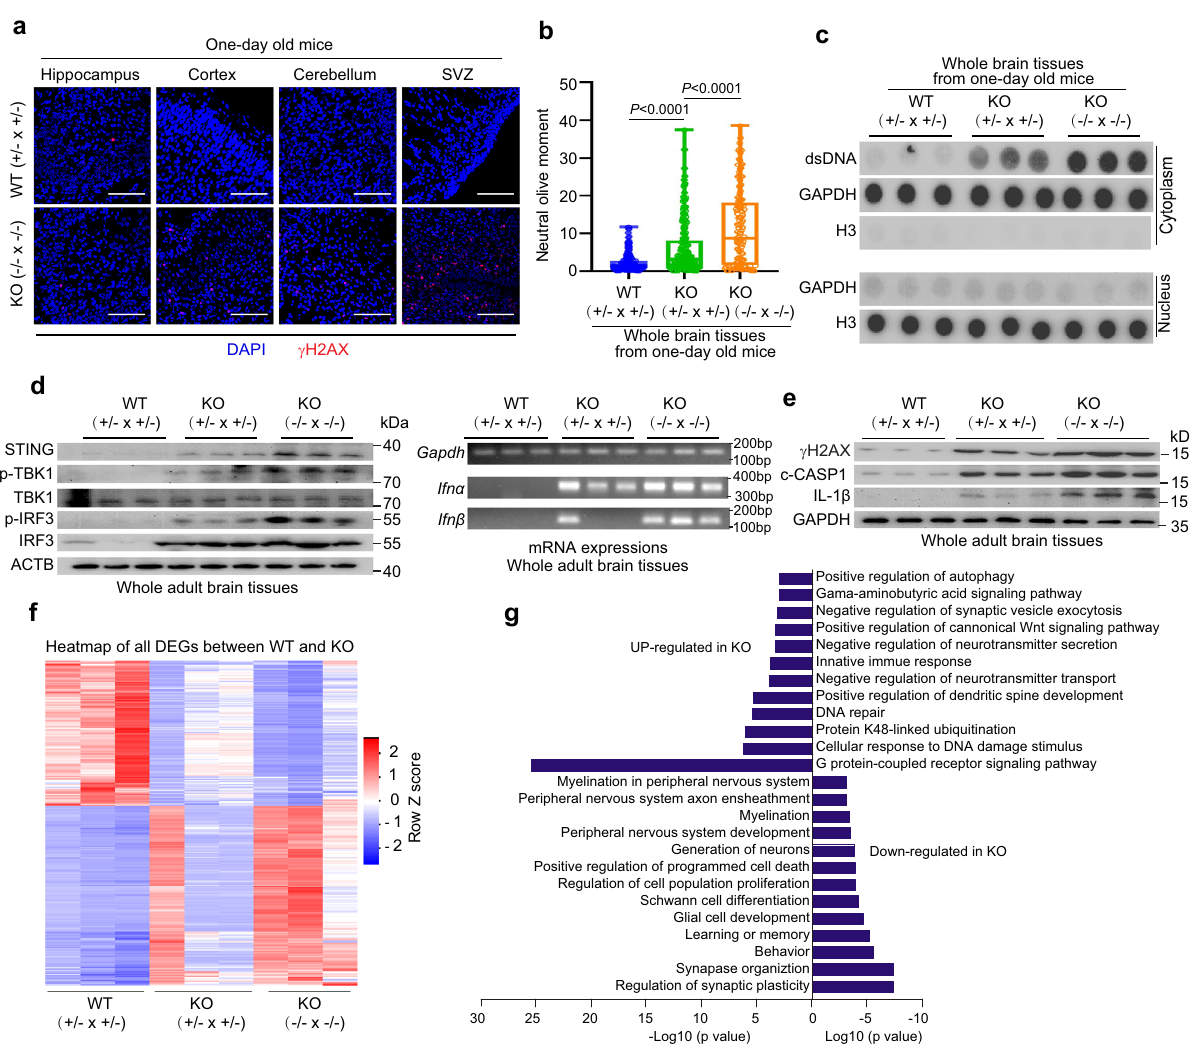
Fig. 7 Discn knockout (KO) in mice induces massive DNA DSBs and immune reaction. Discn KO mouse brains contained higher level of DNA DSBs than WT counterparts, as indicated by γ H2AX staining ( a ) and comet assay ( b ). SVZ, subventricular zone. KO ( + / − × + / − ) indicated the KO mice were from Discn + / − crossing, whereas KO ( − / − × − / − ) indicated the KO mice were from Discn − / − crossing. Scale bar, 100 μ m. At least 100 tails were analyzed in each comet assay group in three independent replications. Data were representative of individual values with box and whiskers plots showing the median, upper and lower quartiles, and minimum and maximum. Two-tailed Student ’ s t -test. c Discn KO mouse brains contained higher level of cytosolic dsDNA than WT mice. Mice were 1 day old in ( a – c ). d The STING pathway was activated in Discn KO mouse brains, as indicated by the phosphorylation of TBK1 and IRF3, as well as the induction of type 1 interferon expression. Three independent experiments were repeated with similar results. e The in fl ammasomes were activated in Discn KO mouse brains, as indicated by the detection of cleaved caspase 1 (c-CASP1) and mature IL-1 β . Three independent experiments were repeated with similar results. f Heatmap of differential expressed genes (DEGs) between Discn KO and WT counterpart mice brains. g Gene ontology (GO) enrichments of DEGs shown in ( f ). Adult mice were used in ( d – g